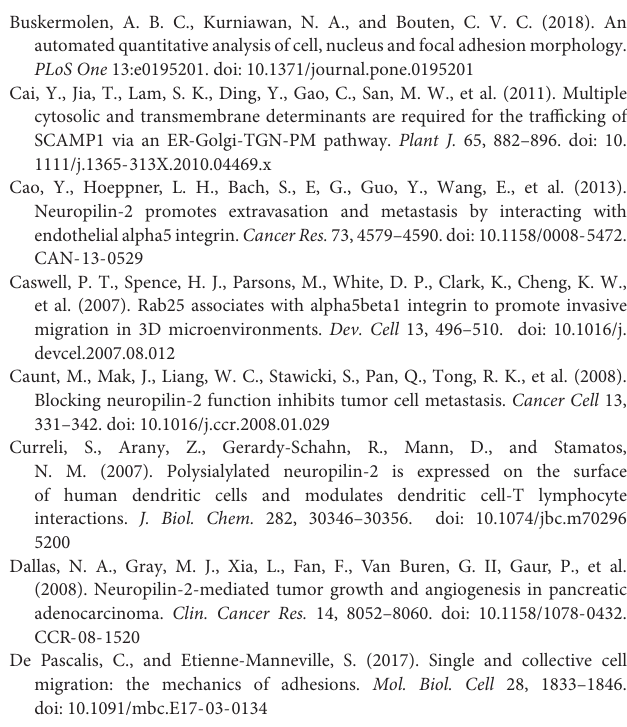
FIGURE S1 | (A) : PyMT transfected mLMEC pellets from nine different immortalized EC lines were subjected to DNA extraction and PCR-based genotyping at the ITGB3 locus. Shown is an agarose gel of P1/P3 and P1/P2 primer products from all EC lines. Lines 1–5 show only a P1/P3 product and are therefore wild-type (WT) for the ITGB3 locus, whilst lines 6–9 show both a P1/P3 product, and a P1/P2 product, and are therefore heterozygous ( β 3HET) for the ITGB3 locus. (B) : Western blot analysis of VE-Cadherin and ITGB3 expression in the same clones shown in (A) . HSC70 was used as a loading control. Because the antibody used for detection of ITGB3 recognizes a non-specific band at approximately (135kDa), a β 3-knockout (NULL) lysate was included as a control (cell line #10). (C) : Left panel shows the densitometric analysis of mean ITGB3 band intensities normalized against HSC70 obtained using ImageJ TM [from the Western blot shown in (B) ]. ∗∗ P < 0.01. (D) : The EC identity of three immortalized EC lines was re-confirmed by Western blot analysis, immunoblotting against additional EC markers Pecam-1, Endomucin, ERG and Claudin-5, alongside a GAPDH loading control and a lymphatic marker Prox-1. (E) : ECs were transfected either with control siRNA or one of four different NRP2-specific siRNAs (01–04) and incubated for 48 h. EC extracts were then subjected to Western blot analysis using antibodies against NRP2, NRP1 and HSC70. Except where noted ( Supplementary Figure S3 ), NRP2 siRNA #03 was used for all subsequent experiments to silence NRP2 expression. (F) : siRNA-transfected ECs were incubated for the indicated timepoints before being lysed and subjected to Western blot analysis using antibodies against NRP2 and HSC70. Asterisks indicate statistical significance from unpaired two-tailed t -tests. (G) : Schematic diagram of the ITGB3 (WT) and (HET) loci, showing where PCR genotyping primers align. P1 and P3 amplify a wild-type product of 446-bp, whilst P1 and P2 amplify a knockout product of 538-bp. FIGURE S2 | (A) : siRNA-transfected ECs were seeded onto FN and incubated for 30 h. ECs were then re-seeded onto FN-coated coverslips, and allowed to adhere for 4 h in serum-free media. Media was then replaced with 10 µ M BrdU in complete culture medium, and the cells incubated for 12 h at 37 ◦ C. ECs were then fixed with 4% PFA, before hydrolyzing the DNA with 1 M HCL. ECs were permeabilized and blocked with Dako R (cid:13) Protein Block Serum-Free. ECs were then incubated with anti-BrdU at 4 ◦ C overnight in a humidified chamber, followed by